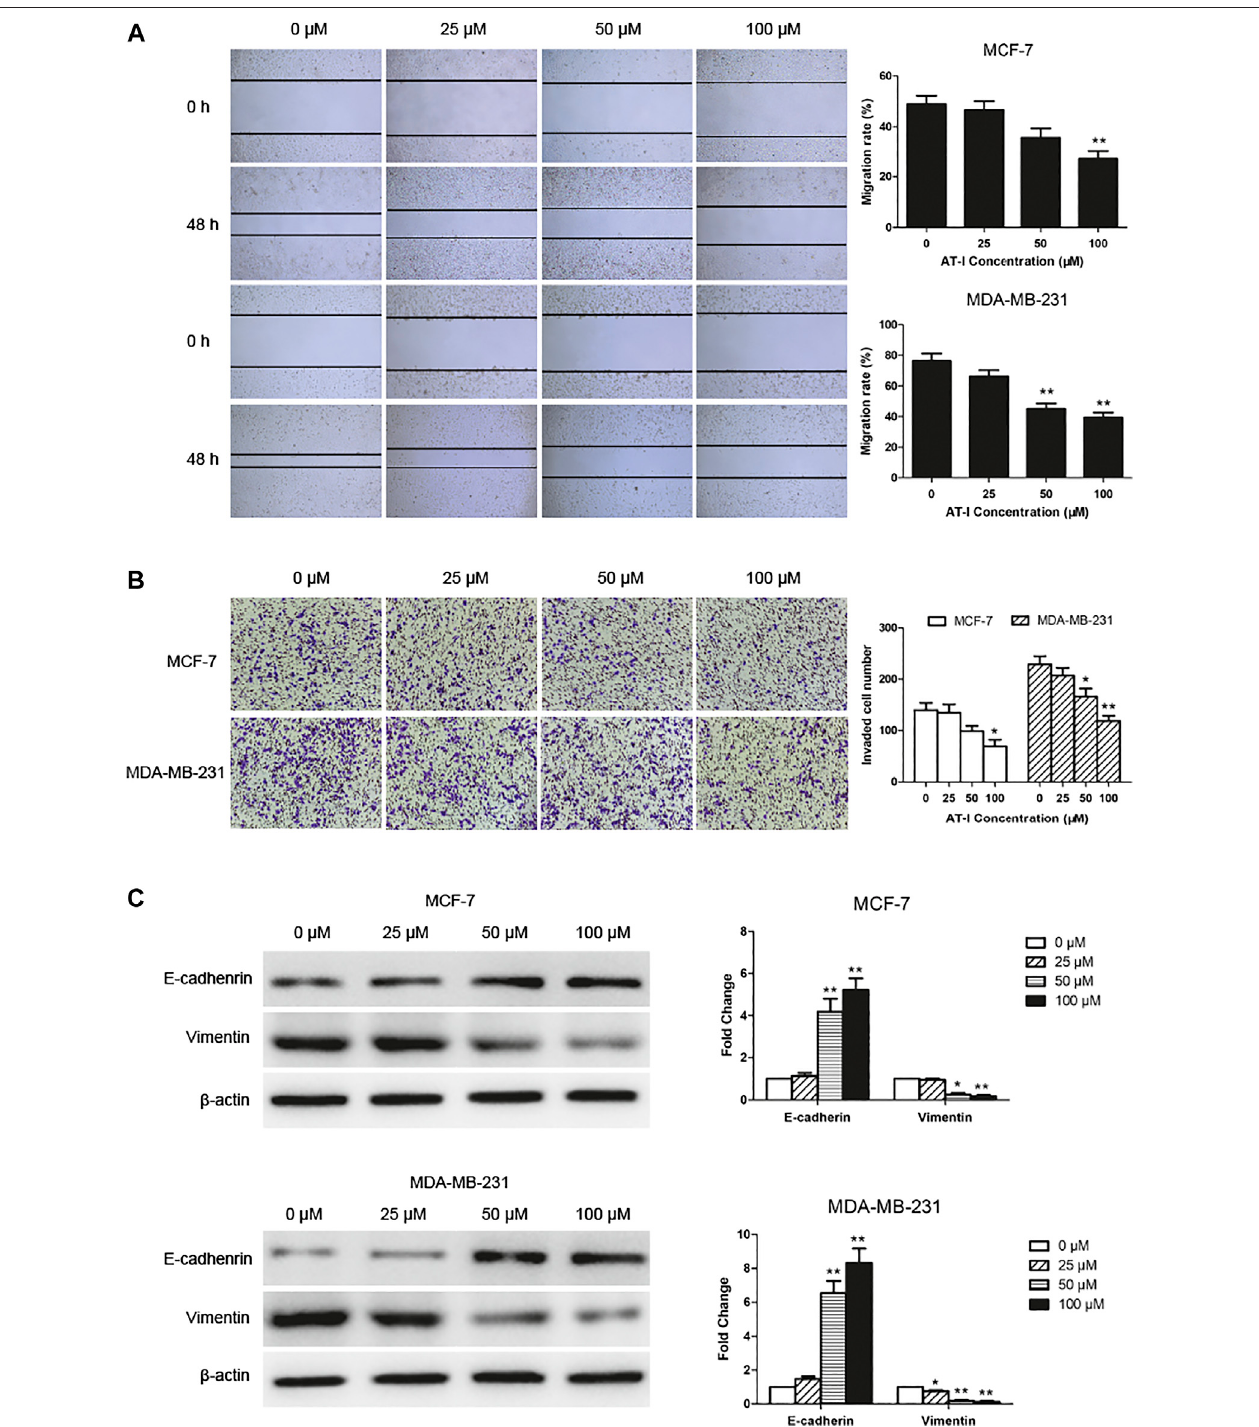
FIGURE 3 | AT-I inhibited cell migration and invasion. (A) The migration capability of MCF-7 and MDA-MB-231 cells were calculated by wound healing assay after treatment with AT-I (0 – 100 µM) for 48 h (40 × magni fi cation). (B) Transwell invasion assay showed the number of invaded cells in MCF7 and MDA-MB-231 cells treated with different concentrations of AT-I (0 – 100 µM) for 48 h (100 × magni fi cation). (C) The effects of AT-I on the expression of E-cadherin and vimentin were measured by western blot assay. Signi fi cant differences between different groups were indicated as * p < 0.05, ** p < 0.01, vs. the 0 μ M control group, n (cid:1) 3.